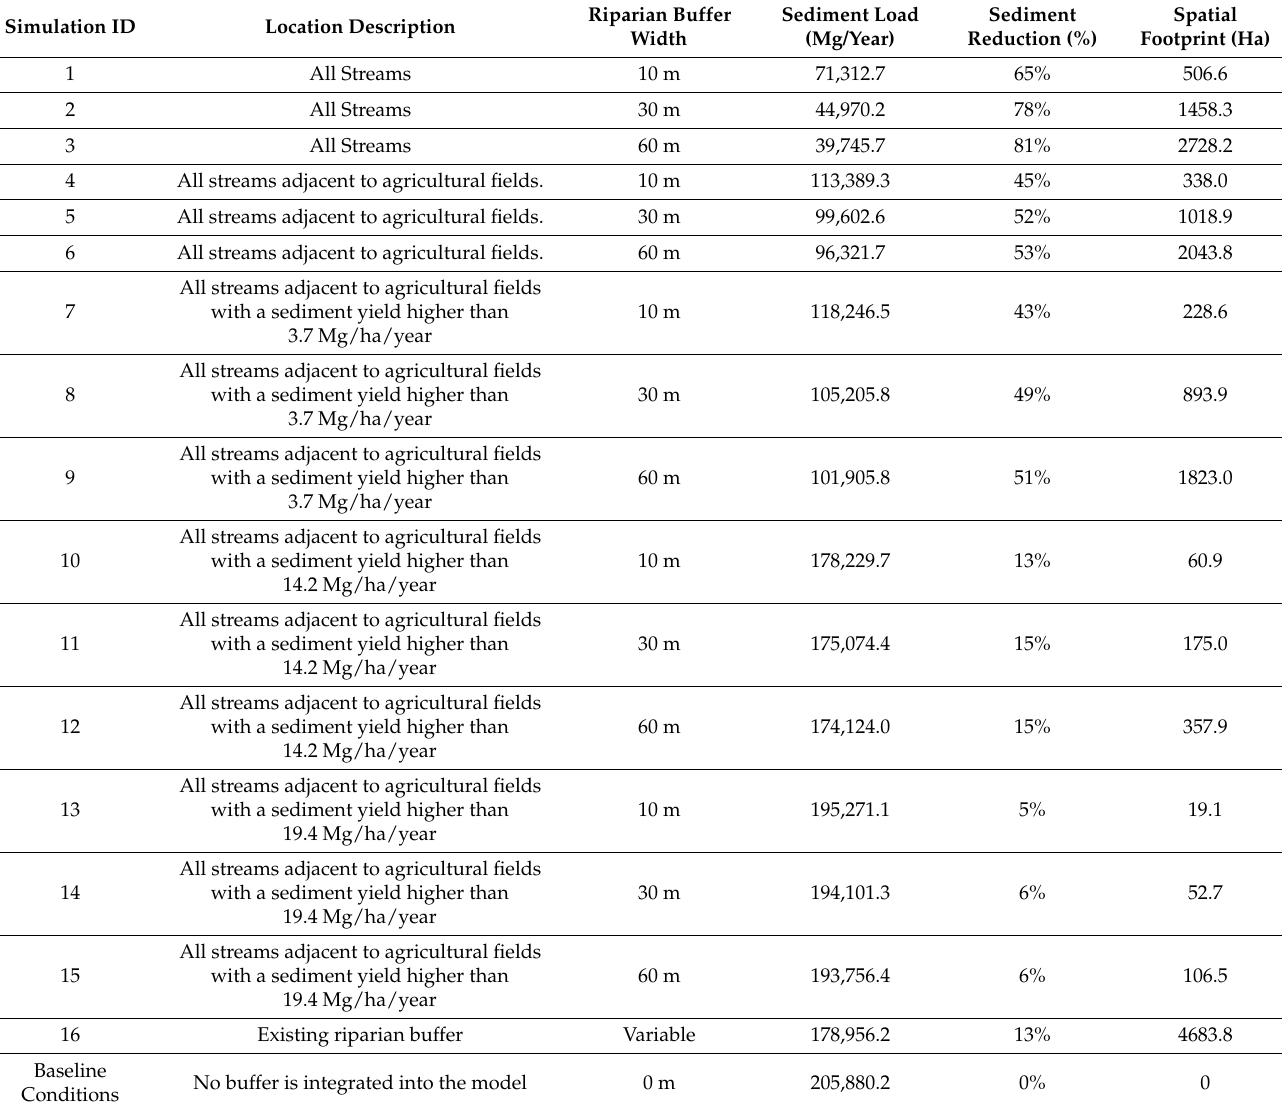
Table 4. Riparian buffer scenarios results.